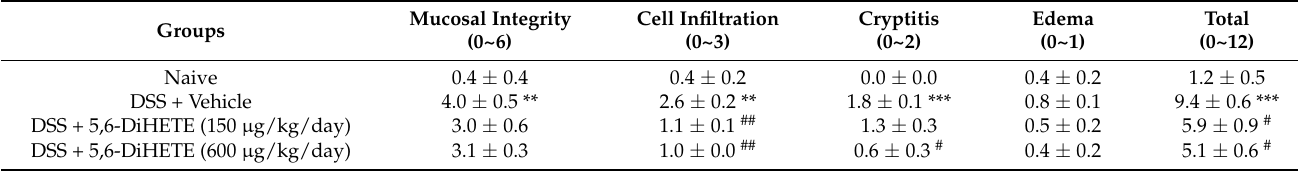
Table 1. Results of histological scoring in each of indices (Mucosal integrity, Cell infiltration, Cryptitis and Edema) and in total.